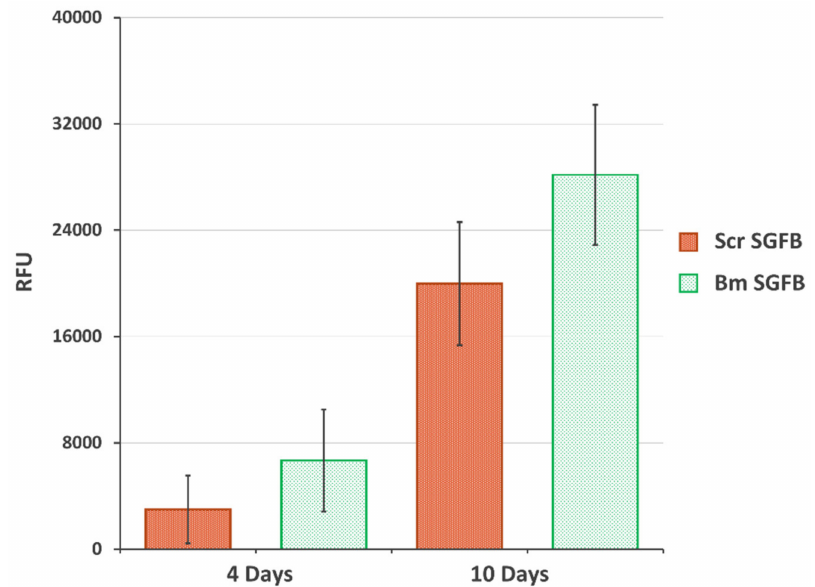
Figure 5. Proliferation of the human dermal fibroblasts growing on the silkworm gut fibre braids produced from silk glands of S. c. ricini (Scr SGFB) and from B. mori (Bm SGFB) at 4 days and 10 days after seeding. Data are expressed as the average values of relative fluorescence units (RFU) (570–610 nm) ± SD ( n = 4) of the PrestoBlue